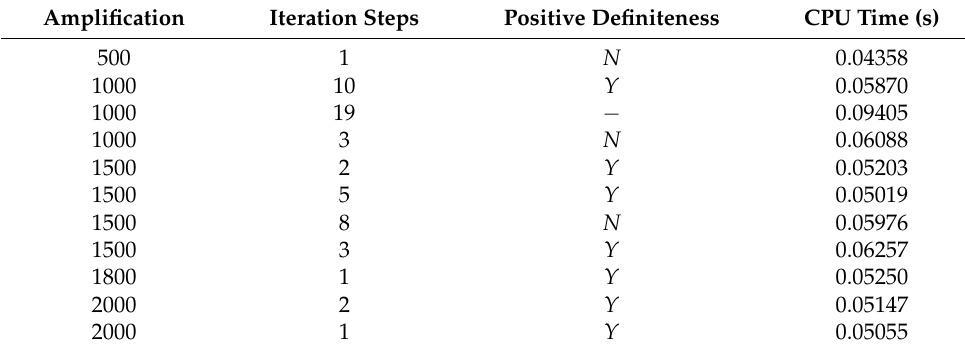
Table 2. Numerical results of Example